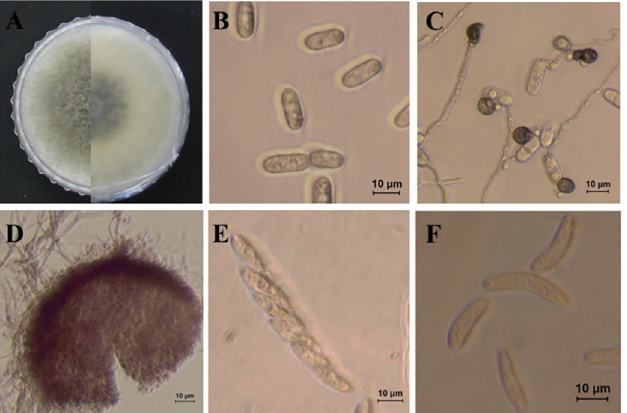
Fig 9. Morphological characteristics of C . fructicola (isolate 3C2). A: Colony on PDA above and below. B: Conidia. C: Appressoria D: Perithecium. E: Ascus. F: